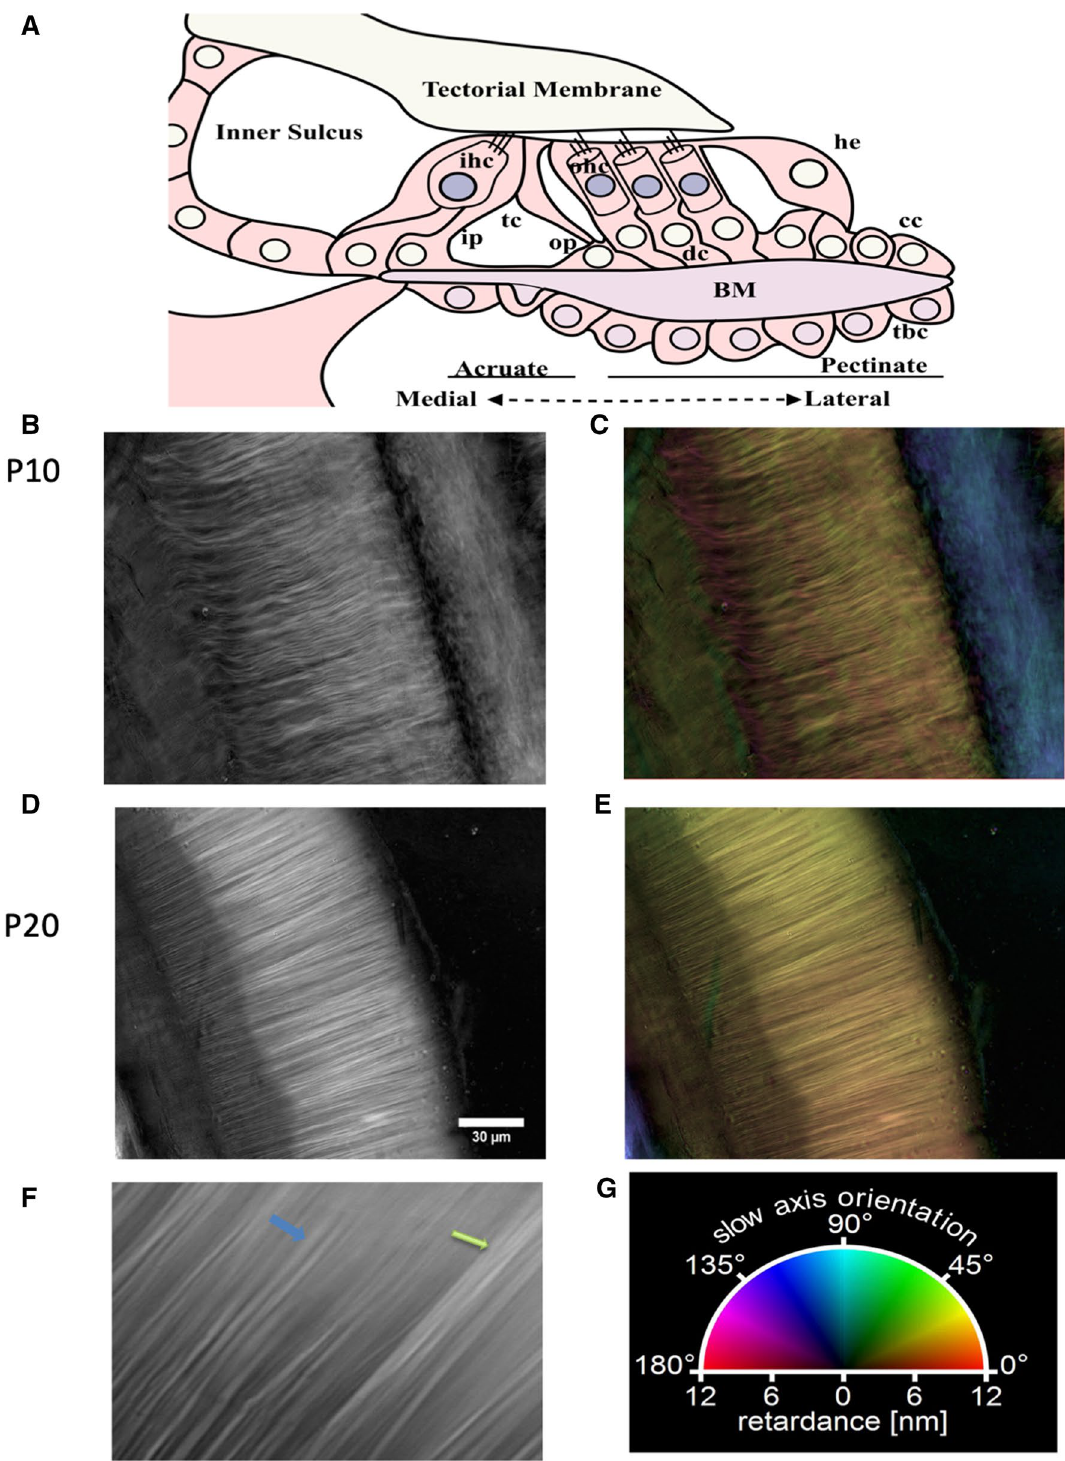
Figure 1. Polarized light images reveal differences in structural signature during basilar membrane development and maturation. ( A ) Schematic of the Organ of Corti ( B , D ) Retardance images of the midturn BM at P10 ( B ) and P20 ( D ). A retardance image represents the measured magnitude of refractive index anisotropy and is the first of the two calculated images in a LC-PolScope image stack. (C , E ) Pseudo color composition of retardance and orientation of the samples in ( B ) and ( C ). The orientation image is the second image in an LC-PolScope stack and is used to determine the hue, while the retardance image is used to determine the brightness of the pseudo- color image. The overall hues of ( C ) and ( E ) represents the slow axis of orientation (see color wheel ( G ). The color variation in ( C ) and ( E ) reveals a great degree of refractive index anisotropy. ( F ) Enlarged section showing the individual fibers, the smallest detectable single unit (blue arrow) and fiber bundles (green arrow). Scale bar length same as shown in ( D ): 5 μm. ( G ) Color wheel shows a visual vectorial representation of orientations. A color wheel correlates the pseudo colors and the slow axis orientation. cc, Claudius cells; cd Deiters Cells; he, Hensen cells; ih, inner hair cell; ip, inner pillar cell; oh, outer hair cell; op, outer pillar cell; tc, tunnel of